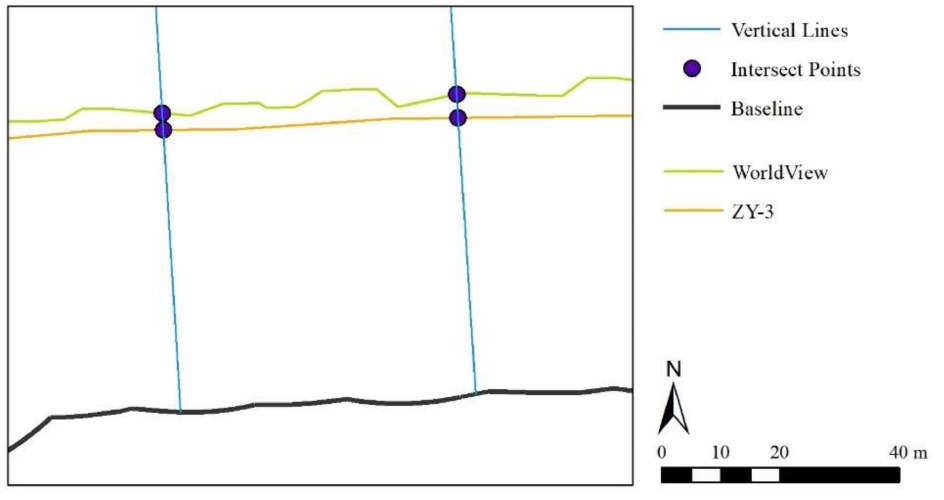
Figure 2. Illustration of accuracy validation.